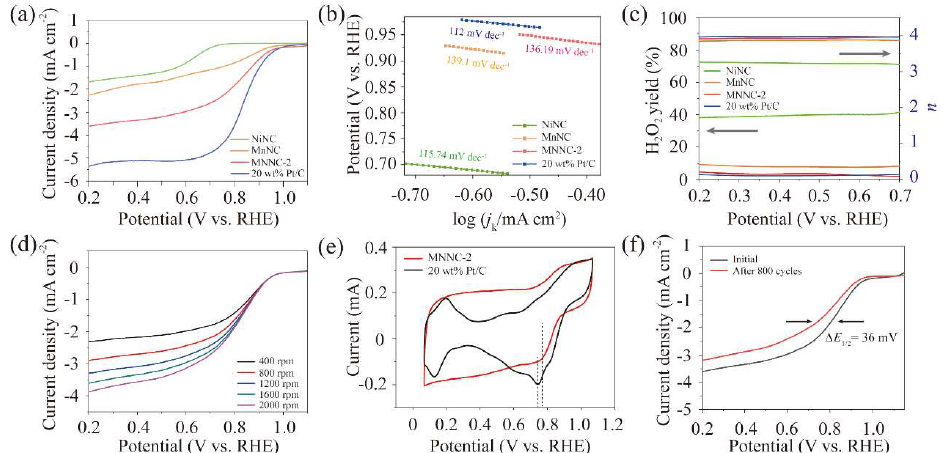
Figure 7. ( a ) LSV polarization curves and ( b ) Tafel plots of MnNC, NiNC, MNNC-2 and Pt/C measured at 1600 rpm in O 2 -saturated 0.1 M KOH. ( c ) Electron transfer number n (right) and H 2 O 2 yield (left) vs. potential for MNNC-2 and Pt/C derived from the RRDE tests. ( d ) LSV curves of MnNC, NiNC, MNNC-2 recorded at different rotation speeds recorded in O 2 -saturated 0.1 M KOH. ( e ) The CV curves for MNNC-2 and 20 wt.% Pt/C catalysts at the scan rate of 10 mV s −1 in O 2 -saturated 0.1 M KOH. ( f ) The stability curves of MNNC-2.